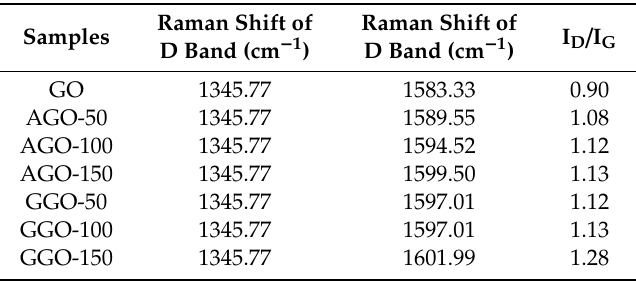
Figure 7. Raman spectra of GO and 3-aminopropyltriethoxysilane functionalized-GO (AGO-50, AGO-100 and AGO-150). Table 1. Summary of the Raman Shift and I D / I G for the